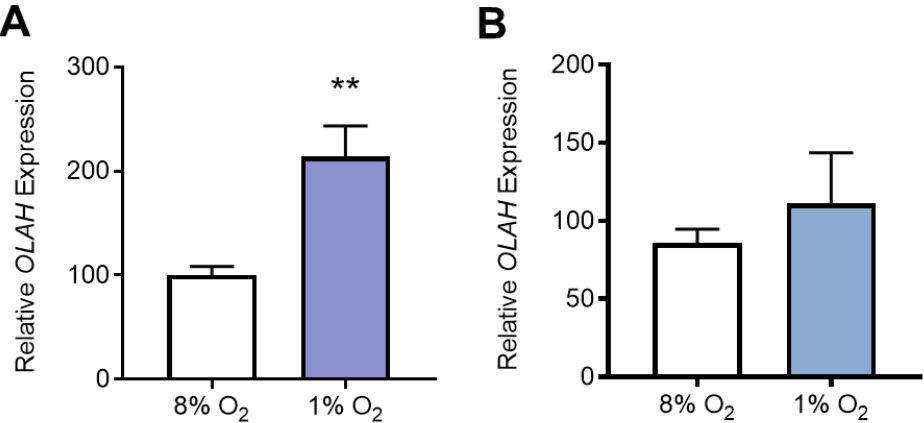
Figure 4. OLAH mRNA expression in term ( A ) placental explant tissue and ( B ) isolated cytotrophoblast cells under hypoxia. Gene expression was assessed by qPCR. OLAH expression was significantly higher in placental explant tissue under hypoxic conditions (1% O 2 ) compared to tissue under normoxic conditions (8% O 2 ) ( A ). There was no significant difference in OLAH transcripts in cytotrophoblast cells under hypoxic compared to normoxic conditions ( B ). Data presented relative to control; mean ± SEM. n = 4–5. ** p < 0.01.